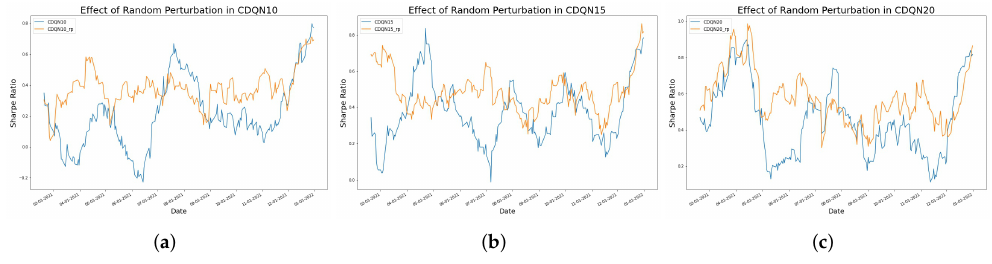
Figure 7. The effect of random perturbation measured by Sharpe ratio for AAPL. ( a ) The left figure shows the comparison between the Sharpe ratio curves with or without the random perturbation technique in CDQN10. ( b ) The middle figure shows the comparison between the Sharpe ratio curves with or without the random perturbation technique in CDQN15. ( c ) The right figure shows the comparison between the Sharpe ratio curves with or without the random perturbation technique in CDQN20.